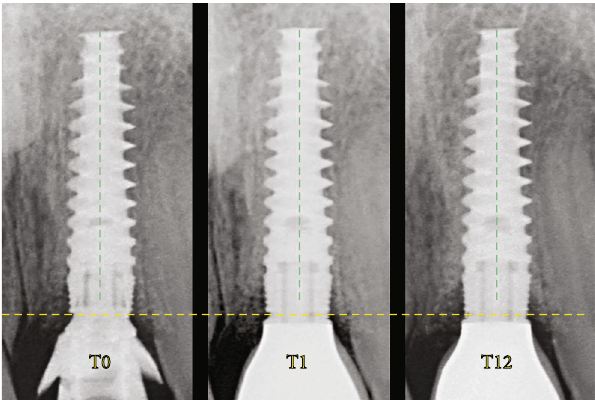
Figure 17: MBL measurement on calibrated intraoral radiographs at T0, T1, and T12.